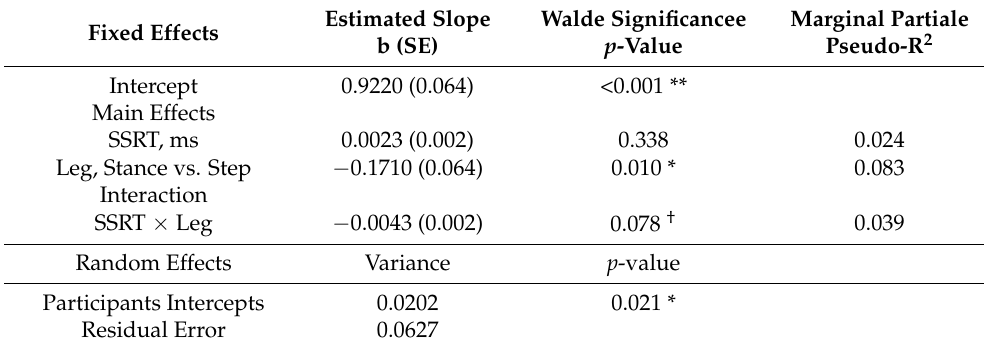
Table 1. Parameter Estimates of a Two-Level Random Intercepts Multilevel Model (MLM-RI) for muscle response ratio (Mean EMG 300ms Reach/Step), where leg (stance or step) moderates the association with the Stop Signal Reaction Time (SSRT, grand mean centered at 193.2 ms). Notes: This single MLM utilized six aggregated muscle response ratios per unique combination of the two legs